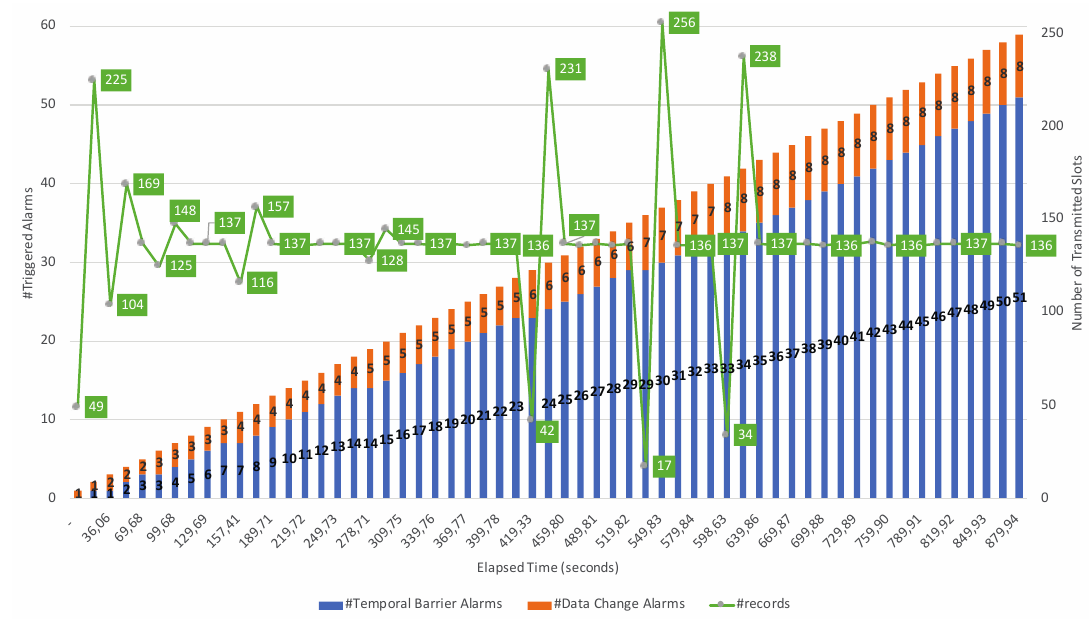
Figure 7. Evolution of the triggered alarms and data transmissions throughout 15 minutes (simulation